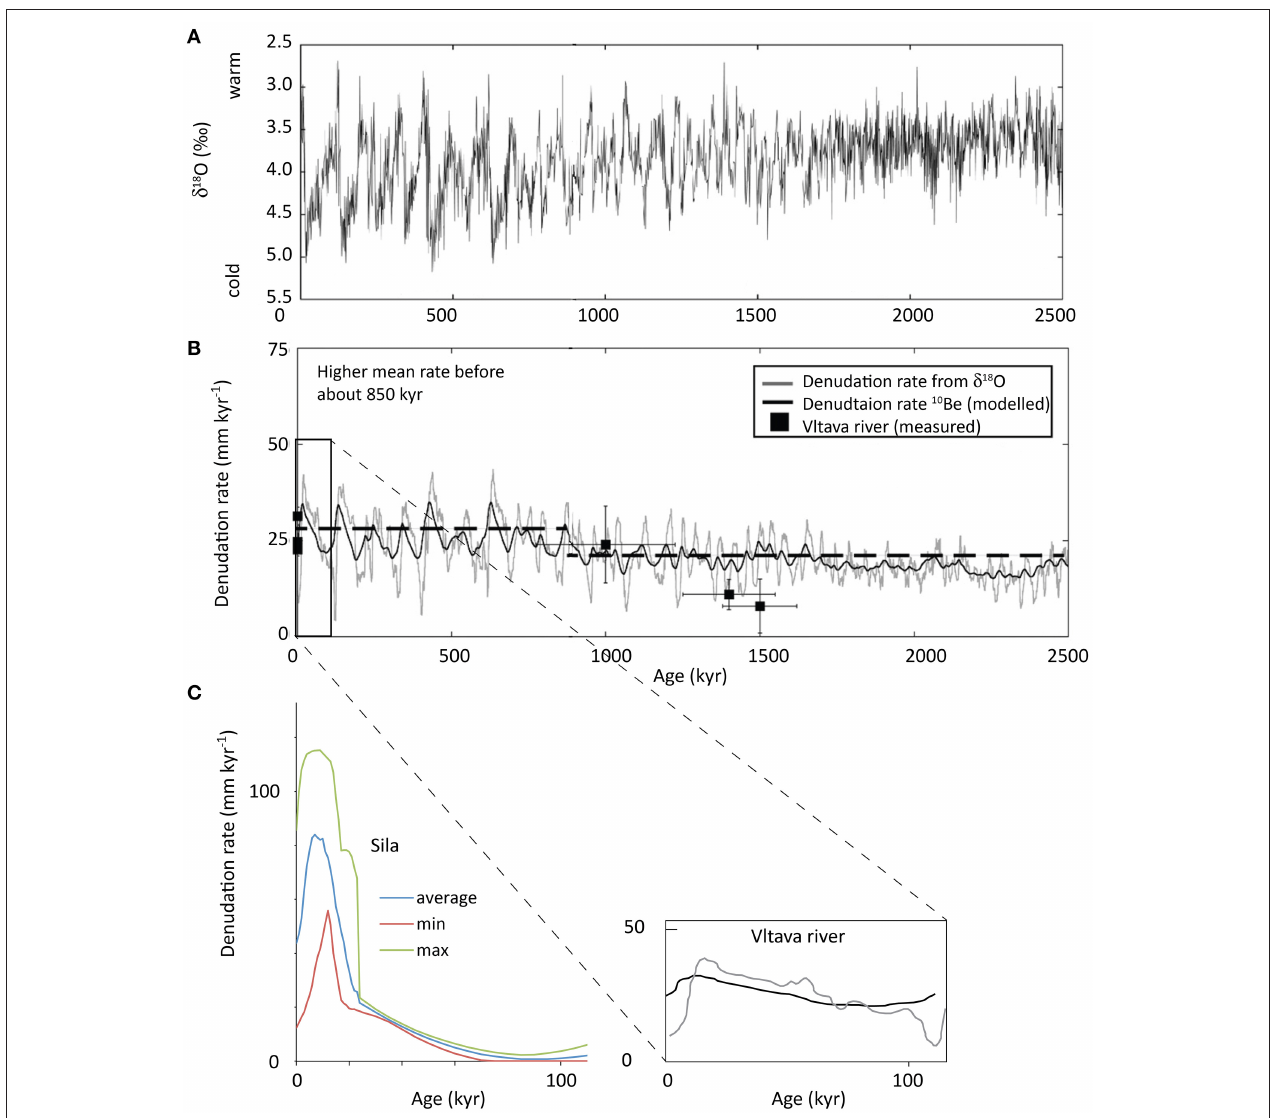
FIGURE 3 | (A) Climate oscillations over the last 2.5 Myr. The δ 18 O values indicate warm and cold stages (Zachos et al., 2001); (B) modeled denudation rates (together with some empirical data of the Vltava river in Central Europe; Schaller et al., 2016) for the same period; (C) variability of the denudation (erosion) rates for the last 100 kyr (data from Schaller et al., 2016 and Raab et al., 2018). Note, similarly to (B) that erosion increases at the transition from cold to warm